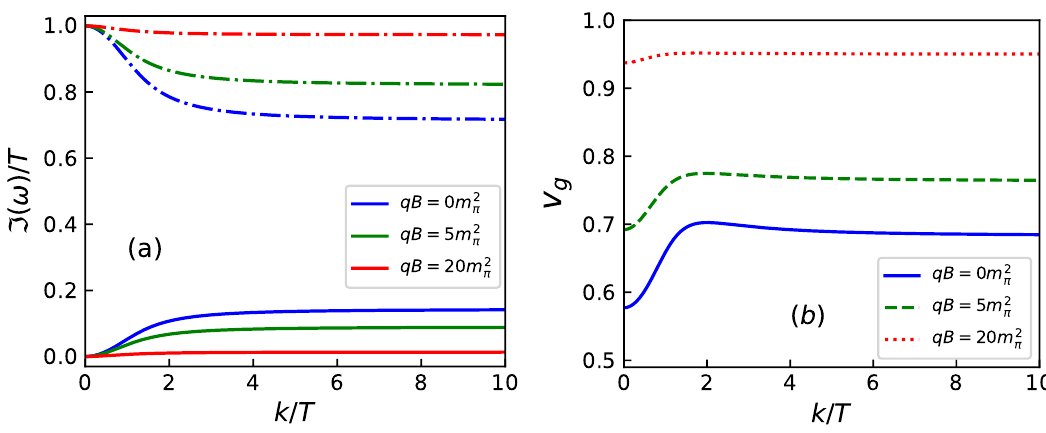
Figure 4 . (Color online) The left panel shows the imaginary parts of ! and the right panel shows the group velocities obtained from the cubic polynomial with the coe(cid:14)cient given in eq. (4.52) for (cid:18) = (cid:25) . The other parameters used are a = 0 : 1 ; (cid:11) = 1 = 3 ; T = 200 MeV ; (cid:28) (cid:25) = 0 : 985 fm and are kept 2 (cid:12)xed for all the curves.In the left panel, the dash-dotted lines represent = ( ! 1 ) and the solid lines are for = ( ! 2 ; 3 ) which are also